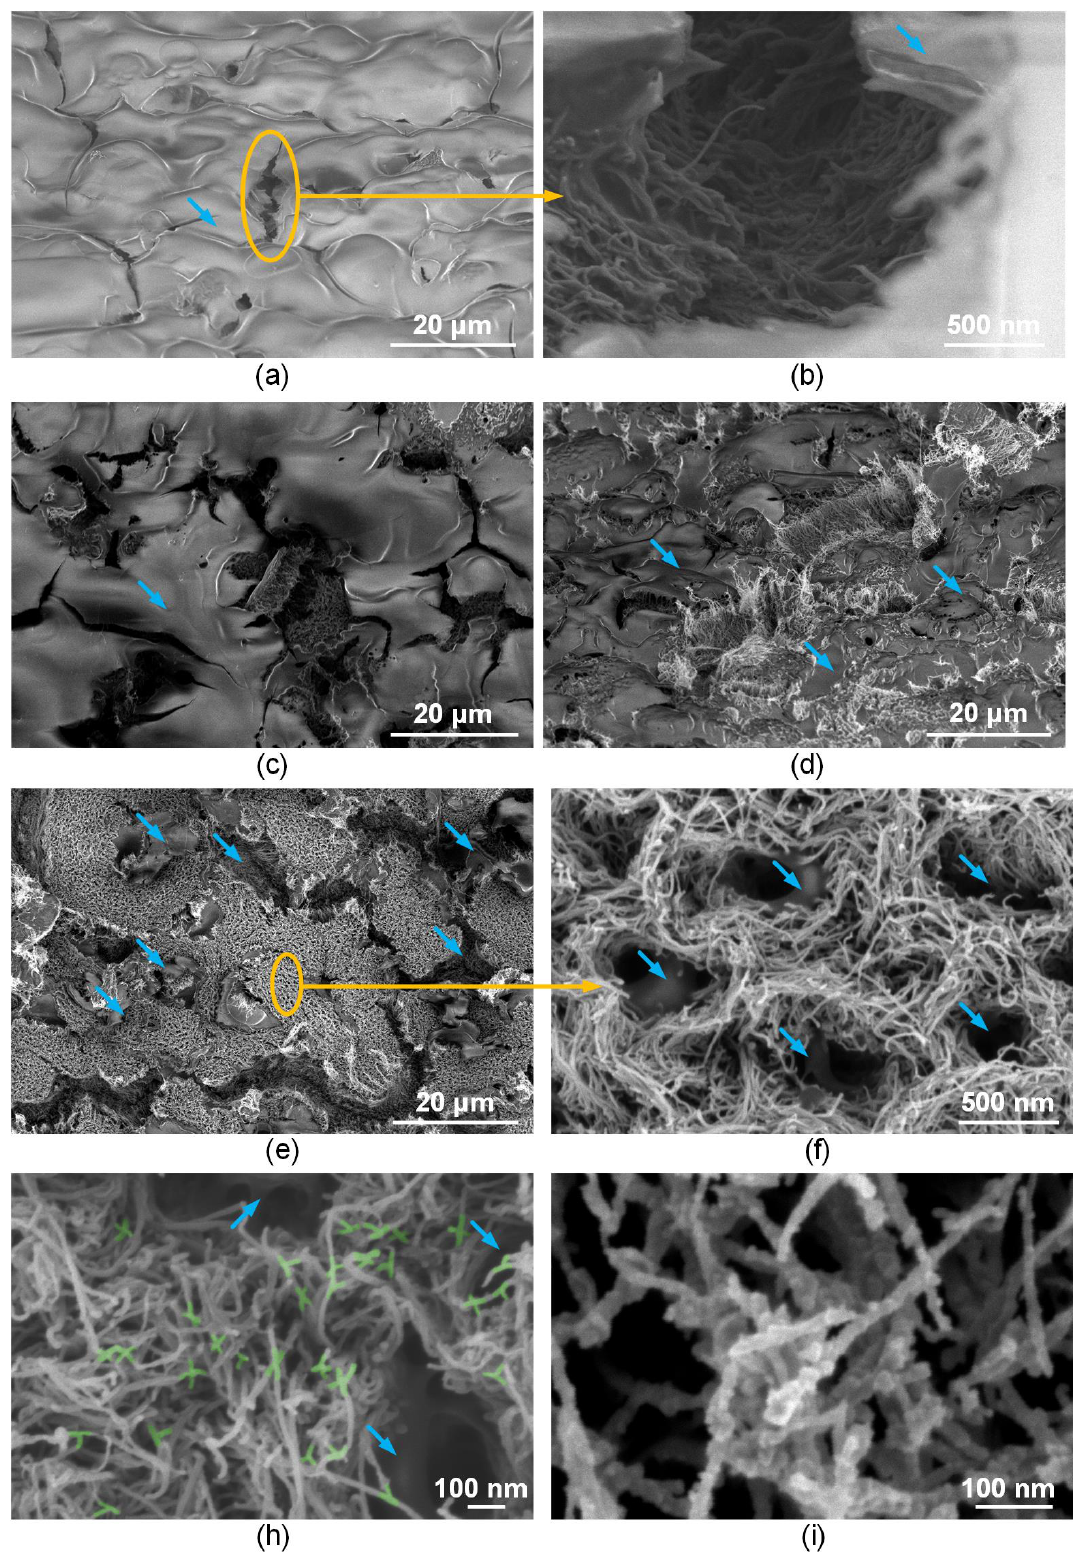
Figure 4. Interfaces based on MWCNT array on Si substrate ( a , b ), and interfaces formed under laser irradiation with an energy density of 0.011 ( c ), 0.013 ( d ), 0.015 ( e – h ), and 0.017 J/cm 2 ( i ) (the blue arrows show the BSA). Nanotube binding regions are highlighted in green.